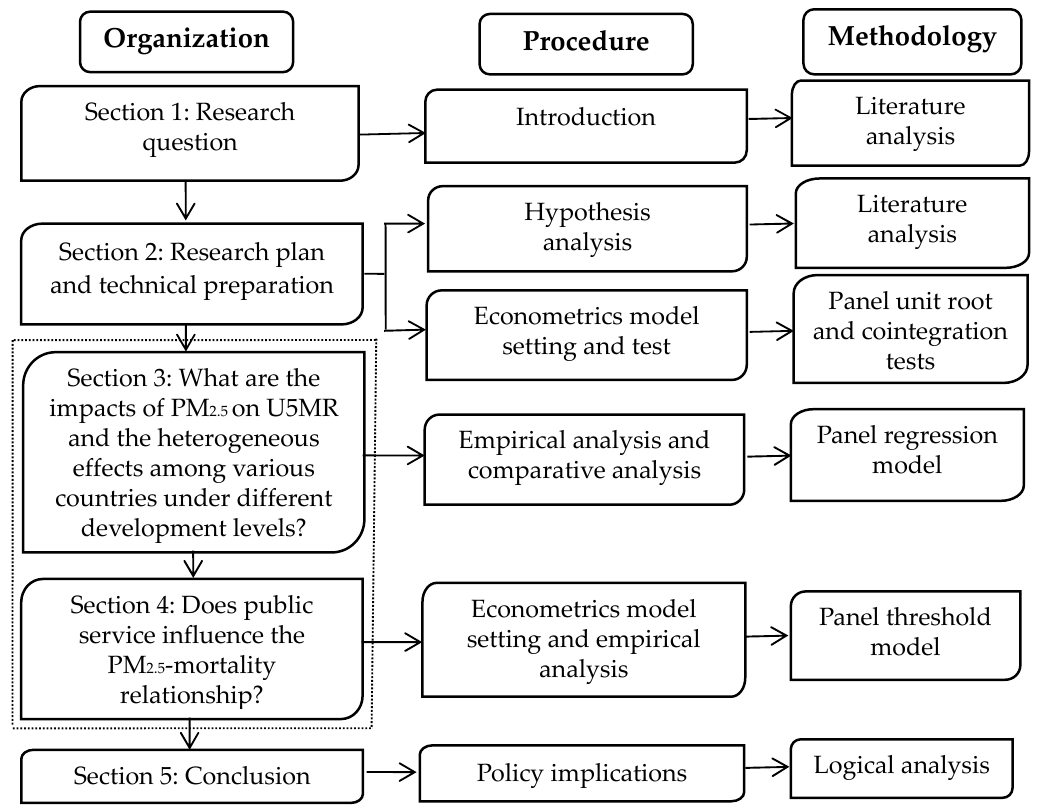
Figure 1. The logical framework of the study.